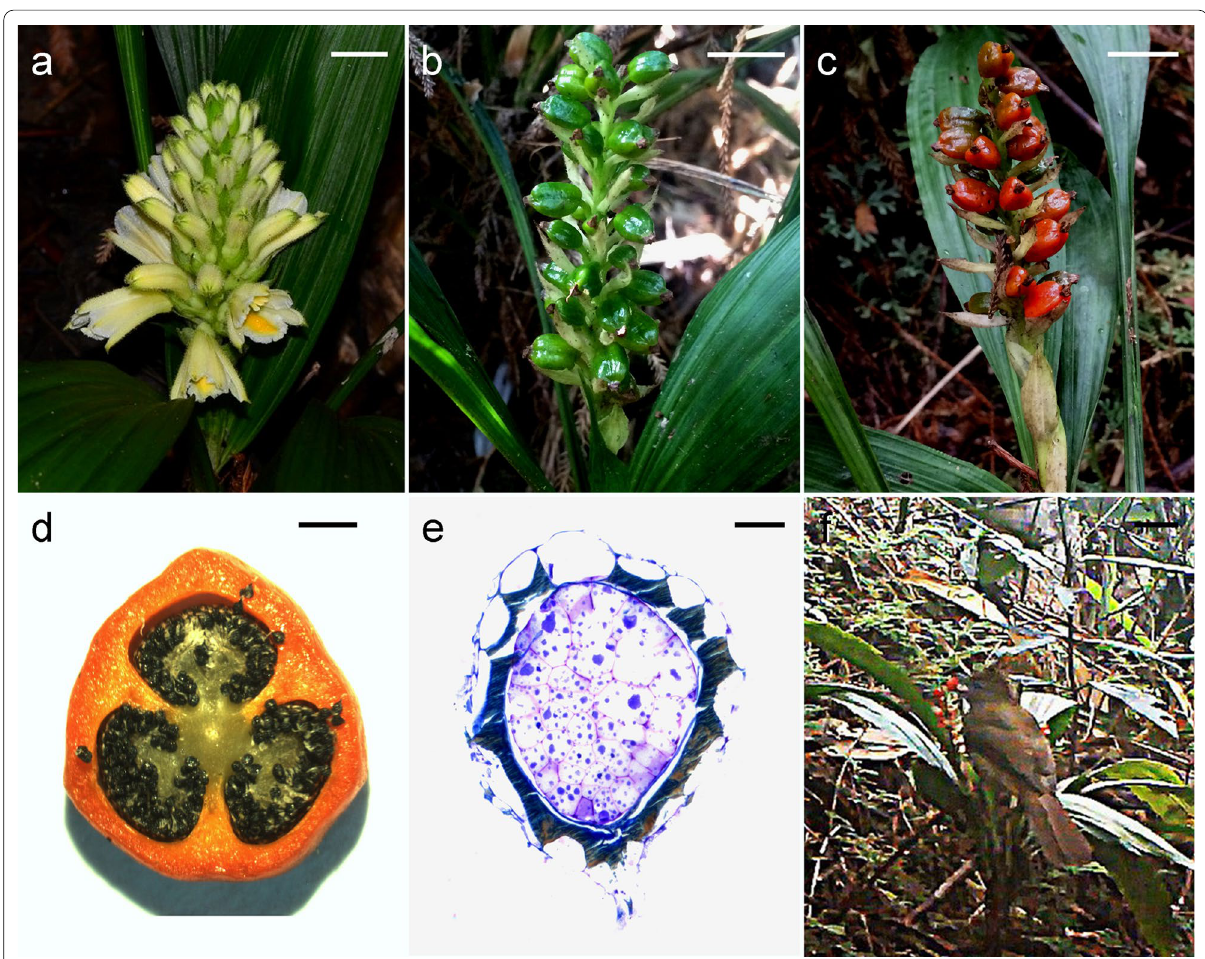
Fig. 1 Flowers, developing fruits and seeds of Neuwiedia singapureana and its dispersal agents. a Flowers.Bar c Mature fruits. Bar 1 cm. d Cross section of a mature fruit. Bar = Bar 60 µm. f A bird feeding on the mature fruits. Bar =